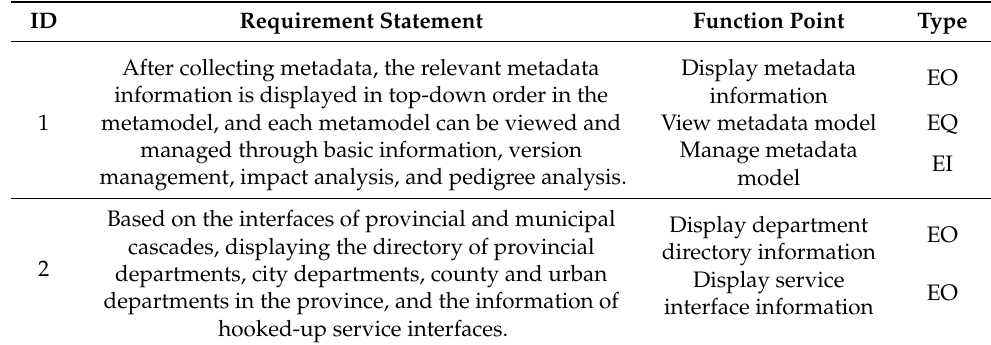
Table 1. Requirement sample from